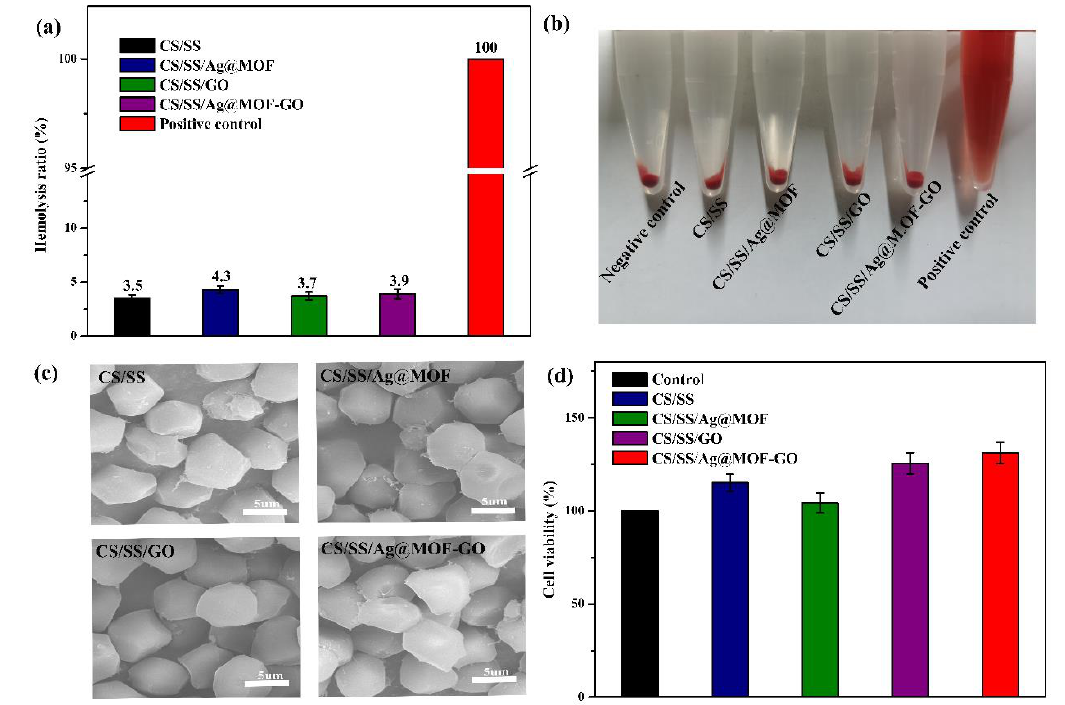
Figure 8. ( a ) Hemolytic percentage of the hydrogels; ( b ) Pictures from the hemolytic activity test of the hydrogels; ( c ) SEM images from the red blood cells morphology treated with the hydrogels; ( d ) Cell viability evaluation of the hydrogels.